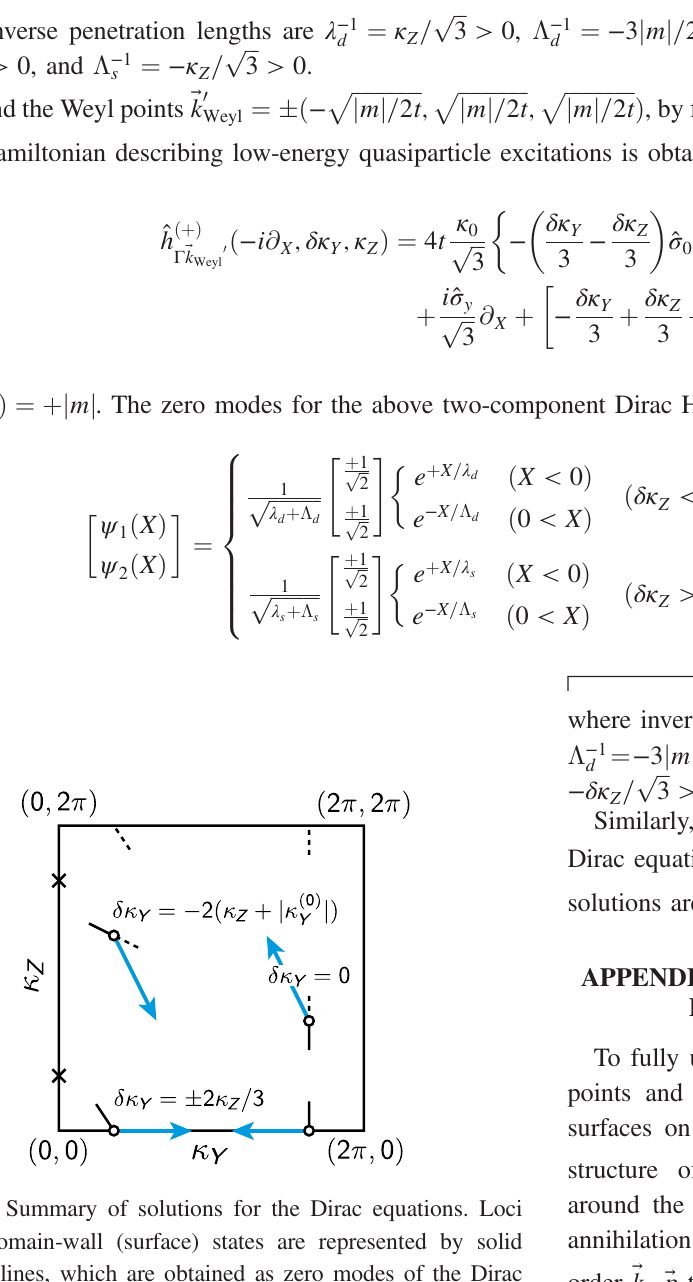
ˆ h ð(cid:2)Þ [see 0 Γ ~k Weyl